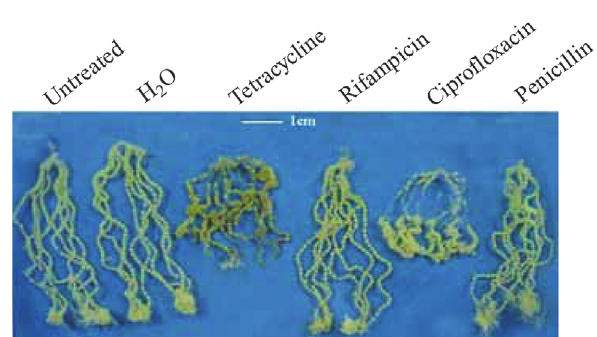
Figure 5 - Phenotype of ovaries after antibiotic treatments. The two groups of H 2 O and untreated were used as control. The groups of tetracy- cline and ciprofloxacin treatment showed an abnormal ovary phenotype compared with that in the control groups.